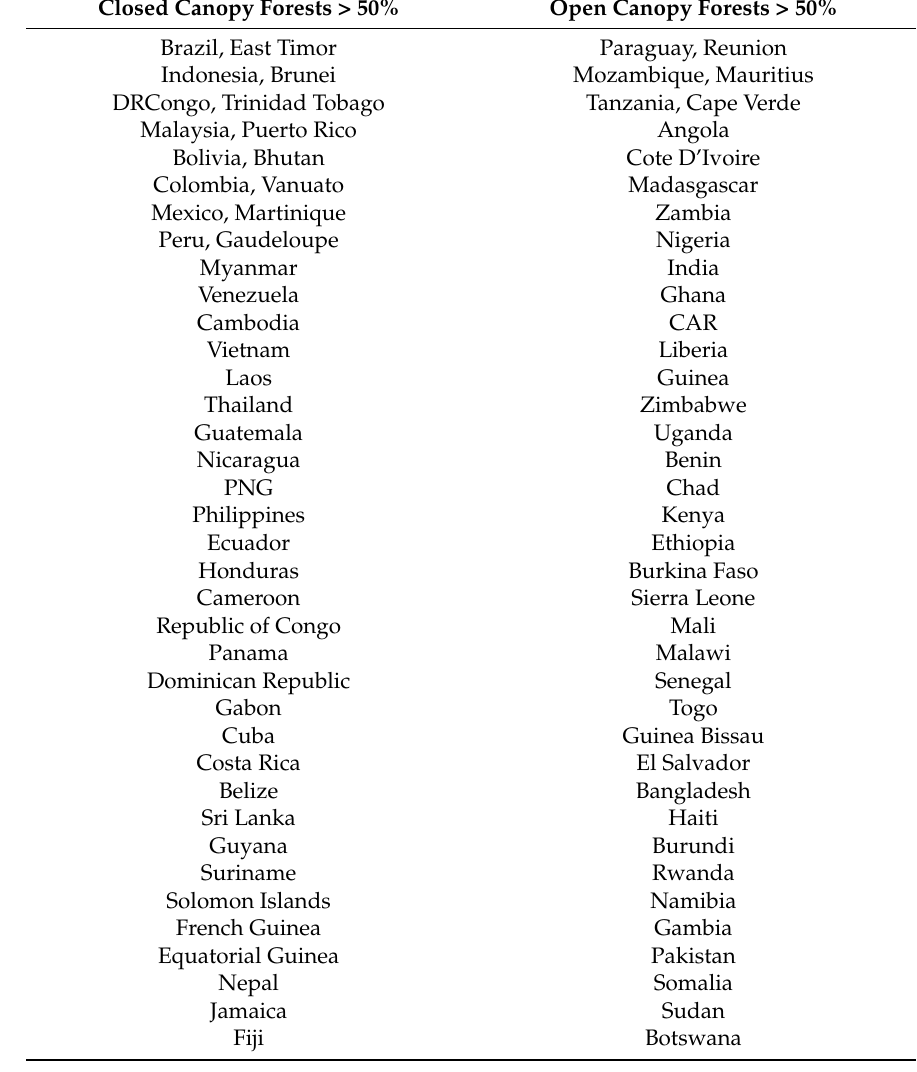
Table A1. Tropical Nations with Predominantly Closed Canopy (Wet) Forests or Open Canopy (Dry) Forests: Ordered beginning on left in column, then top to bottom, by Largest to Smallest Forest Losses, 2000–2012 in km 2 (Top to Bottom): Source: Hansen et al. [10].